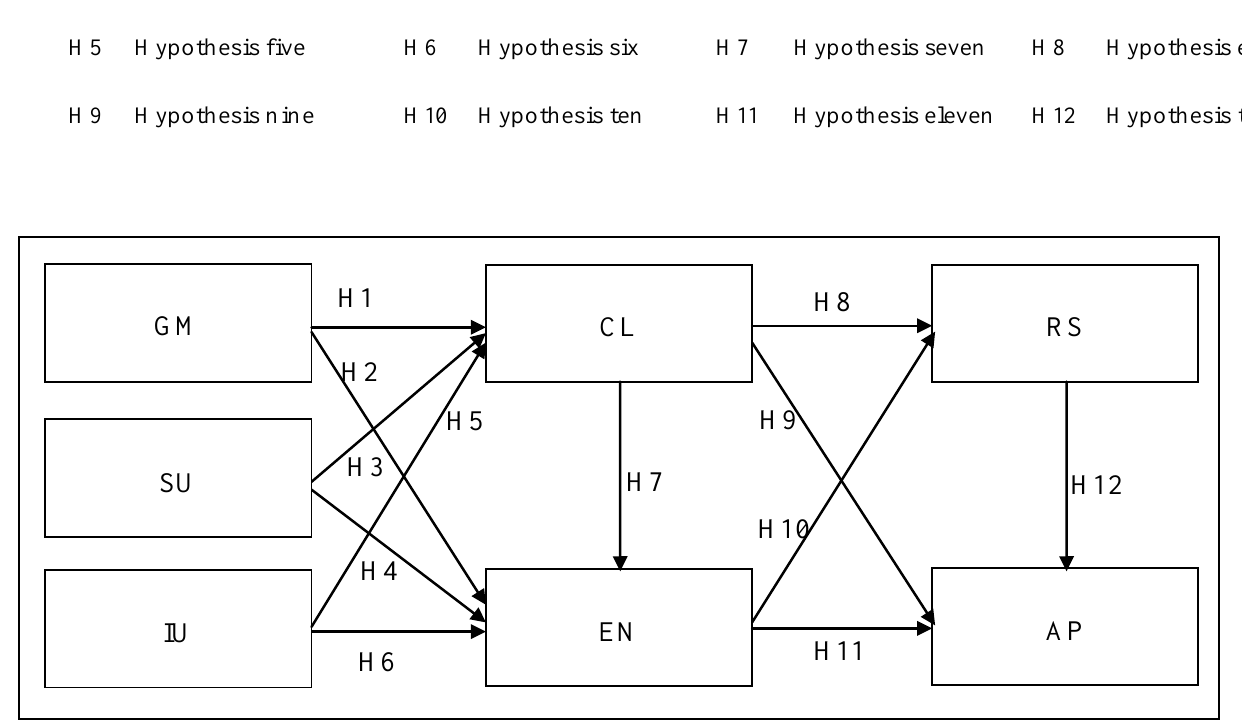
Figure 1 . The research framework with hypotheses